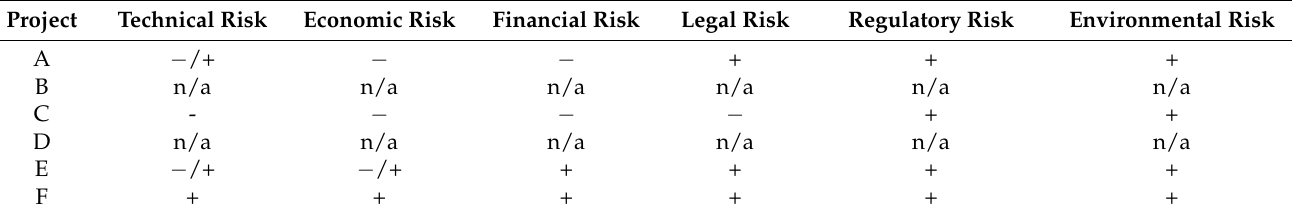
Table 13. Assessment of risks during the operation phase of CHP